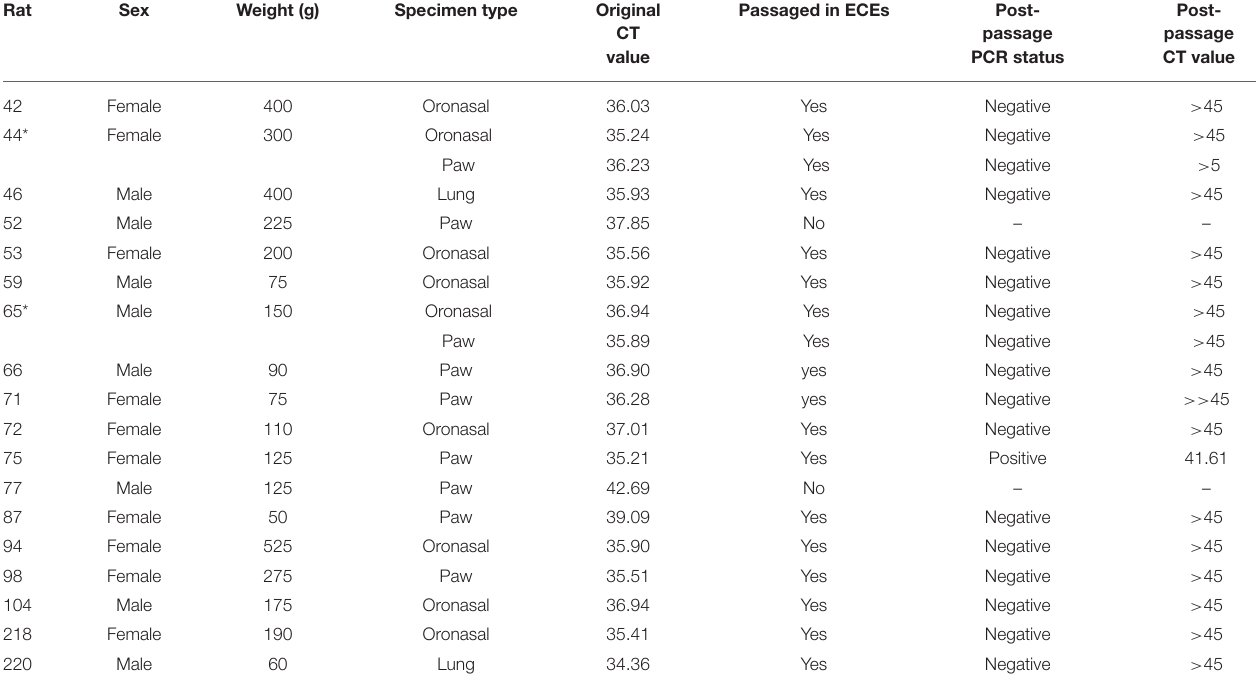
TABLE 1 | Summary of real time-PCR-positive samples from rats.